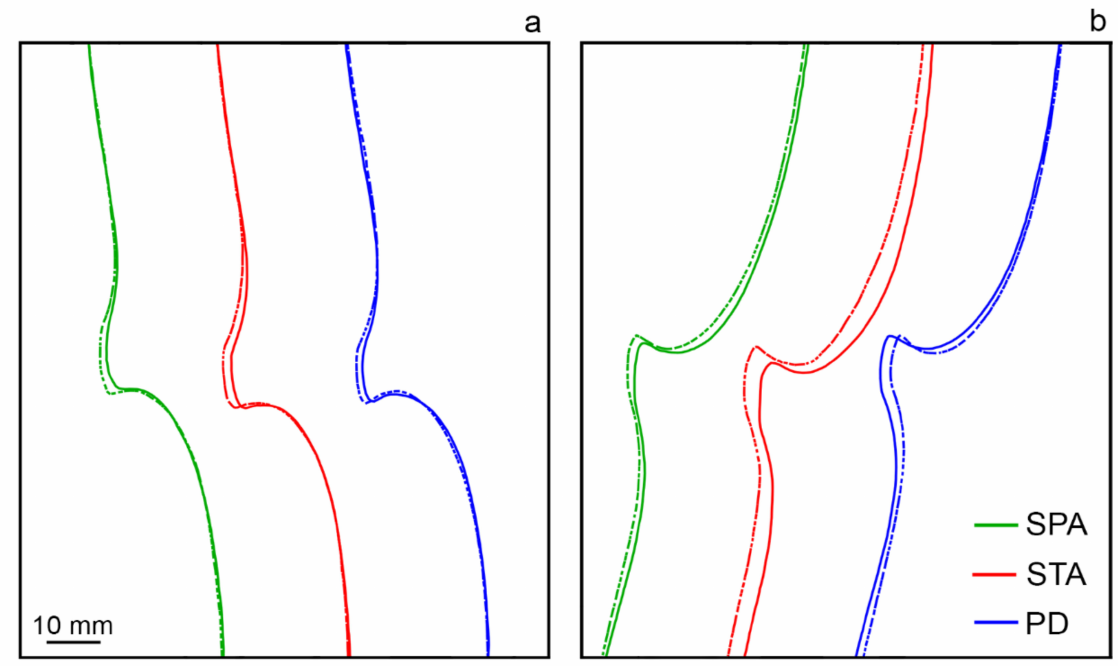
Figure 6. Outlines of the upper ( a ) and lower ( b ) corners of the “Spagnoletti” (SPA), the “Stauffer” (STA), and the “Principe Doria” (PD). In both images, the dotted lines are related to the left corners while the solid lines to the right ones. The f-holes are the most different features among the three violins (Figure 7) in terms of position and dimensions. As reported in Table S1, the f-holes of the “Spagnoletti” and the “Stauffer” show similar a length of around 77 mm, whereas the ones of the “Principe Doria” are noticeably smaller in the total length (right hole: 74.59 mm, left hole: 75.41 mm). In terms of their width at the center (o, p, q in Table S1), they present similar values, except for the lower lobe distance in the “Principe Doria”, where a larger variation between left and right holes is